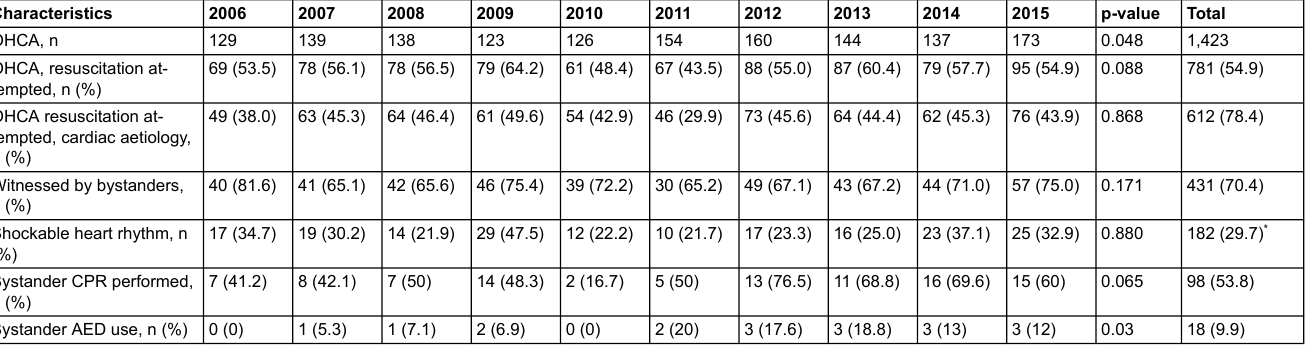
Table 2: The Utstein form of our analysed population. Characteristics